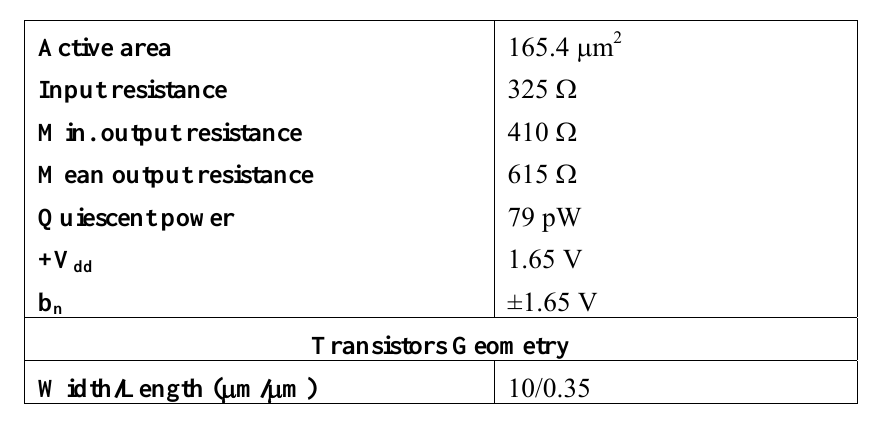
Figure 5. Non-linear (logistic) output circuit.